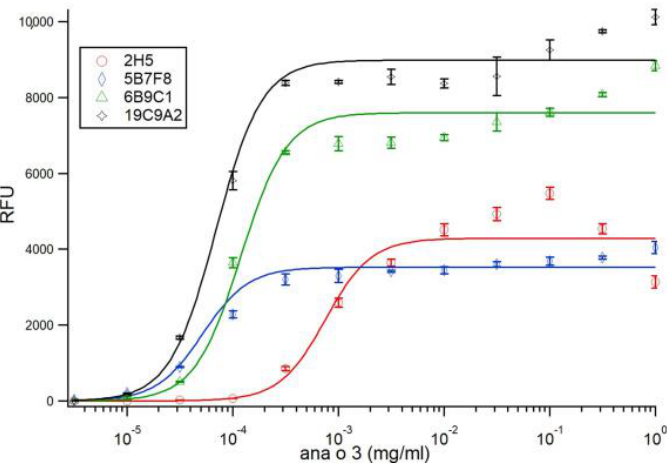
Figure 3. Comparison of monoclonal antibody binding to Ana o 3. Anti-Ana o 3 antibody binding to untreated and DTT- treated purified native Ana o 3 ( A ). Anti-Ana o 3 antibody binding to native Ana o 3 purified from ready-to-eat (RTE) or dark roasted cashew nuts ( B ). Anti-Ana o 3 antibody binding to DTT-treated or untreated purified recombinant Ana o 3.0101 (rAna o 3) ( C ). Relative fluorescence units (RFU) are indicated on the y -axis. Data represent the average of at least four independent samples, and error bars included show ± standard deviation.